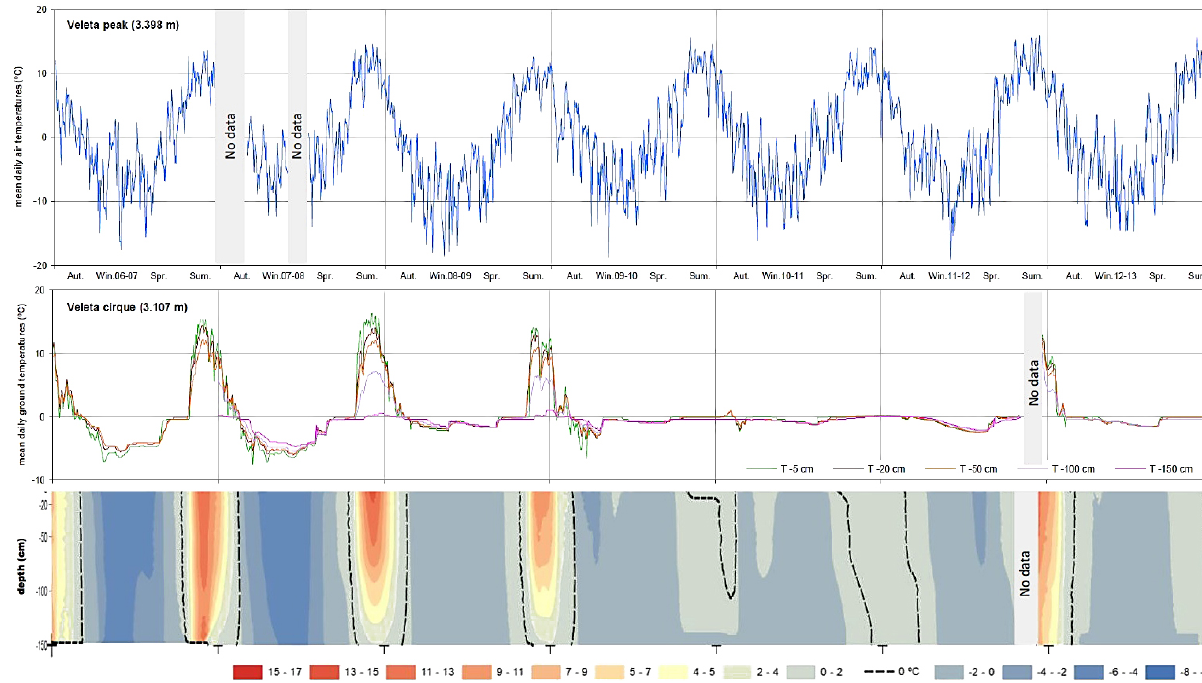
Figure 5. Annual rhythm of ground temperatures at the heart of the rock glacier for 2006–2013. Table 1. Characteristics of the continuous core (modified from Gómez Ortiz et al.,